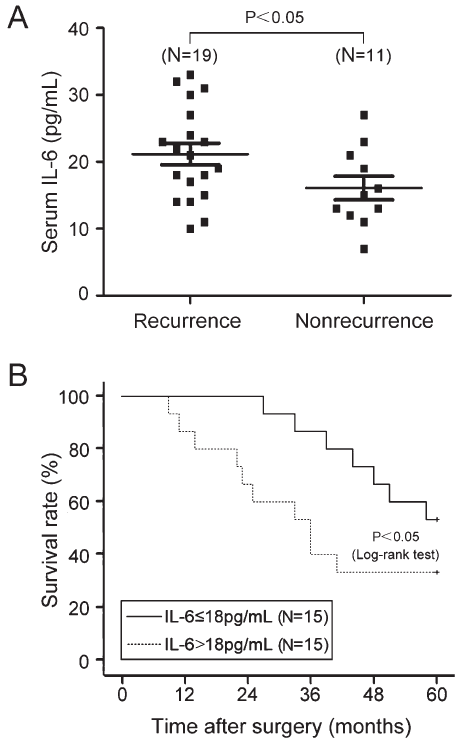
Figure 1. Serum IL-6 is a predictor of survival in hepatocellular carcinoma patients. A , Comparison of serum IL-6 concentration